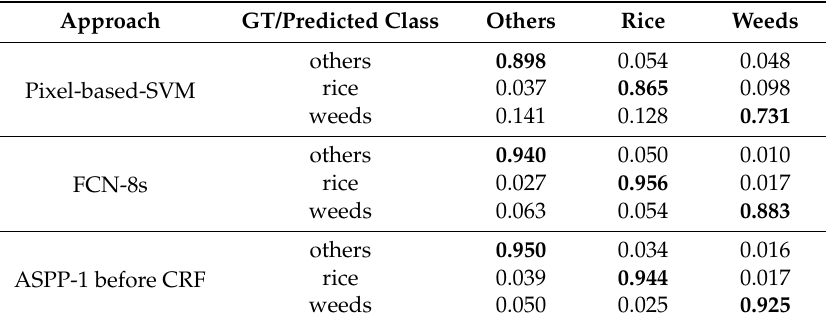
Table 9. Confusion matrix of FCN-8s and our